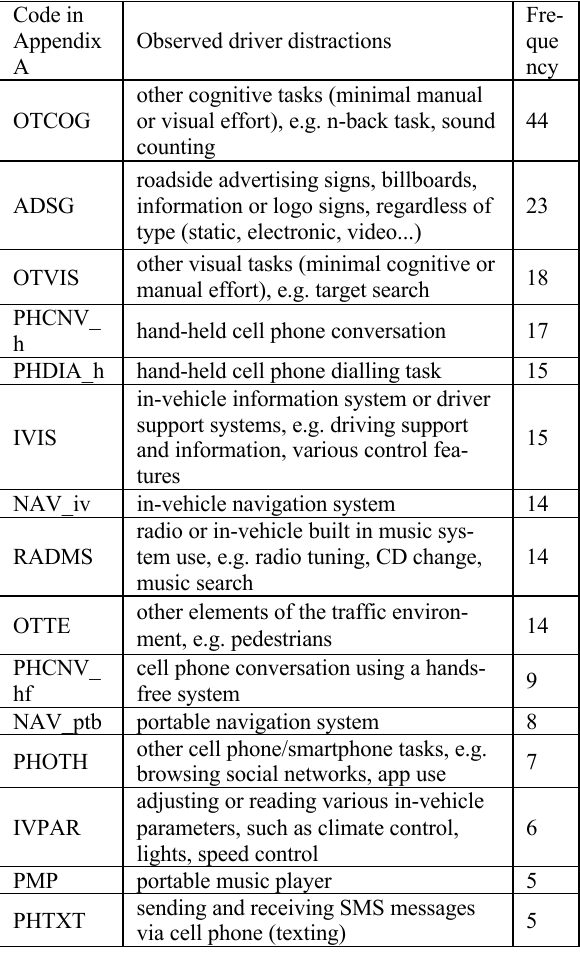
Table 3. Frequency of observed driver